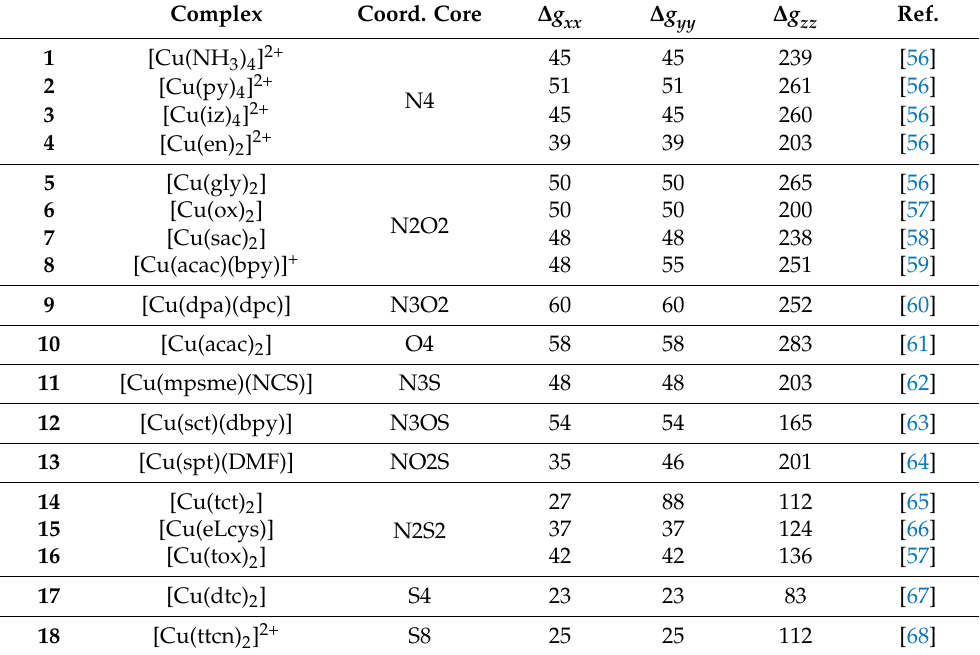
Table 1. Experimental ∆ g values (ppt) of the Cu(II) complexes 1–18 studied in this work. Molecular structures of the complexes are shown in Figure 1. The complexes are arranged in groups according to the copper-coordinating atoms for each subgroup, which are also shown for